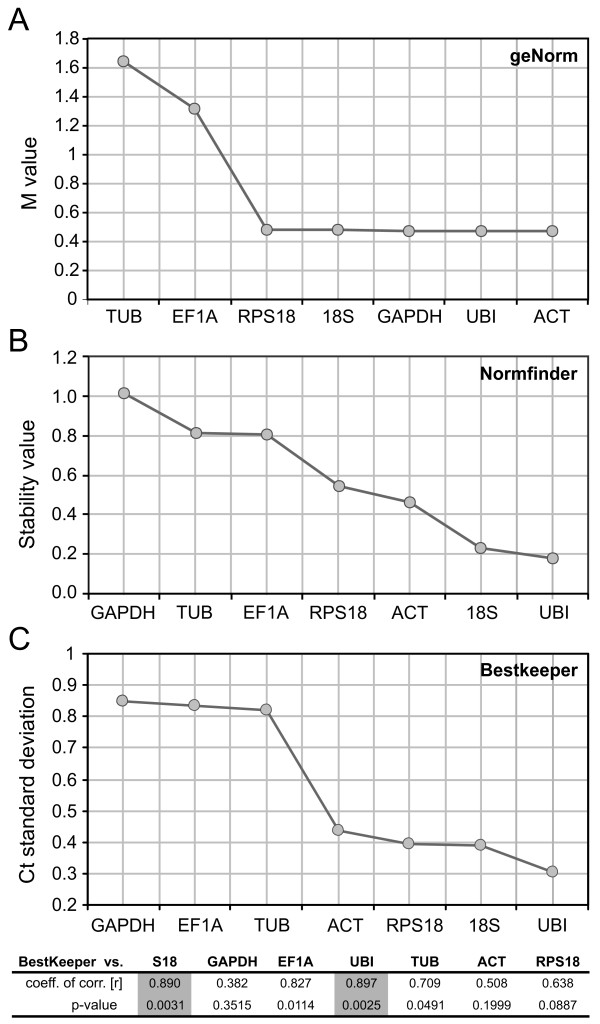
Stability analysis of the candidate reference genes in Delphacodes kuscheli adult planthoppers. The housekeeping genes were ranked according to their expression stability by (A) geNorm, (B) Normfinder and (C) BestKeeper statistical tools. In the three plots, genes were ordered from least (left) to most (right) stable. Pair-wise correlation analysis between the candidate reference genes and the calculated BestKeeper index is also shown (C, bottom) and the higher correlated genes were highlighted in grey.